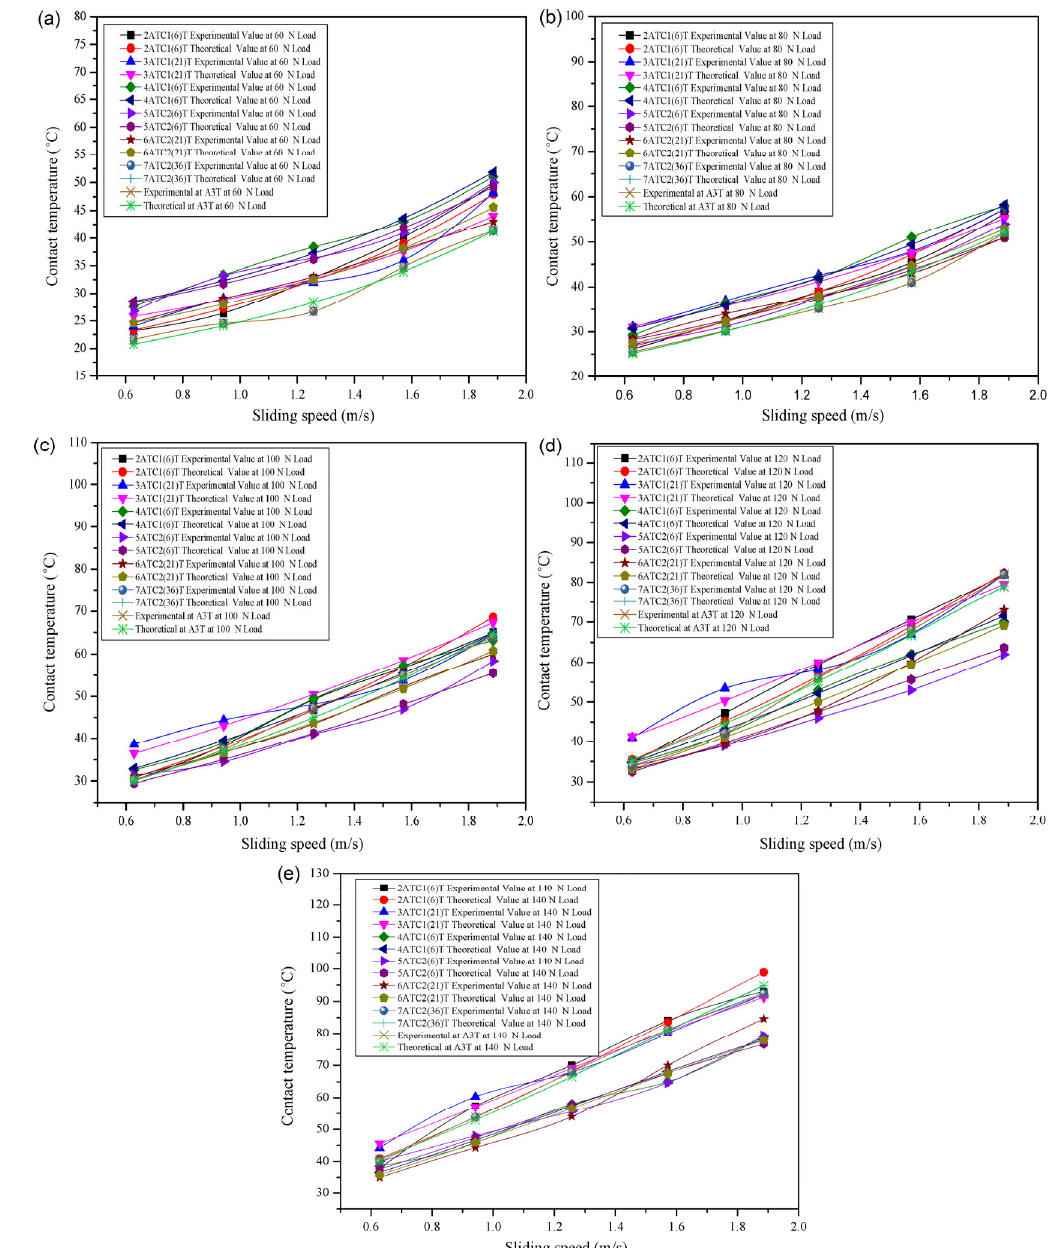
Fig. 19 Comparison of the theoratical and experimental results for the rise in contact temperature during the wear test at varying sliding speeds and loads: (a) 60 N, (b) 80 N, (c) 100 N, (d) 120 N, and (e) 140 N in the case of various treatments: A3T, ATC1(6)T, ATC1(21)T, ATC1(36)T, ATC2(6)T, ATC2(21)T, and